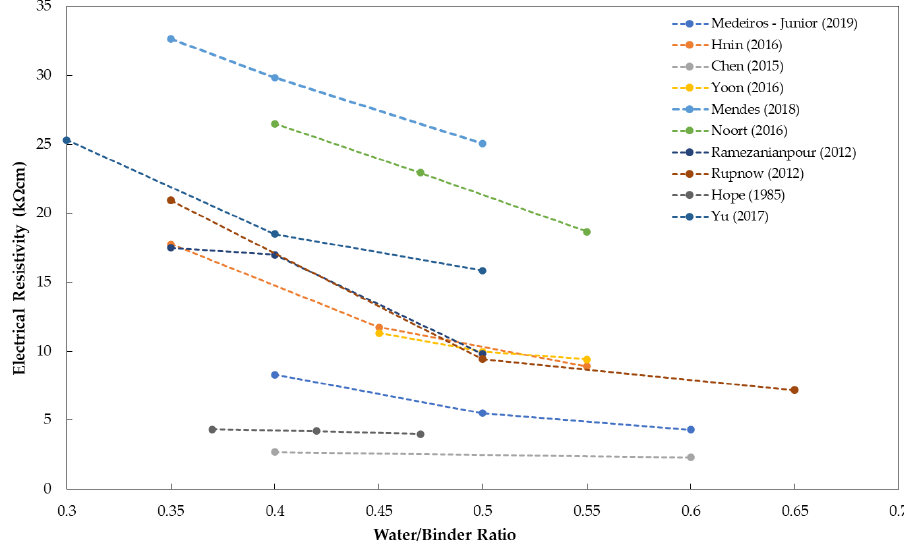
Figure 7. Summary of references showing the relationship between electrical resistivity and water-to-cement ratio.